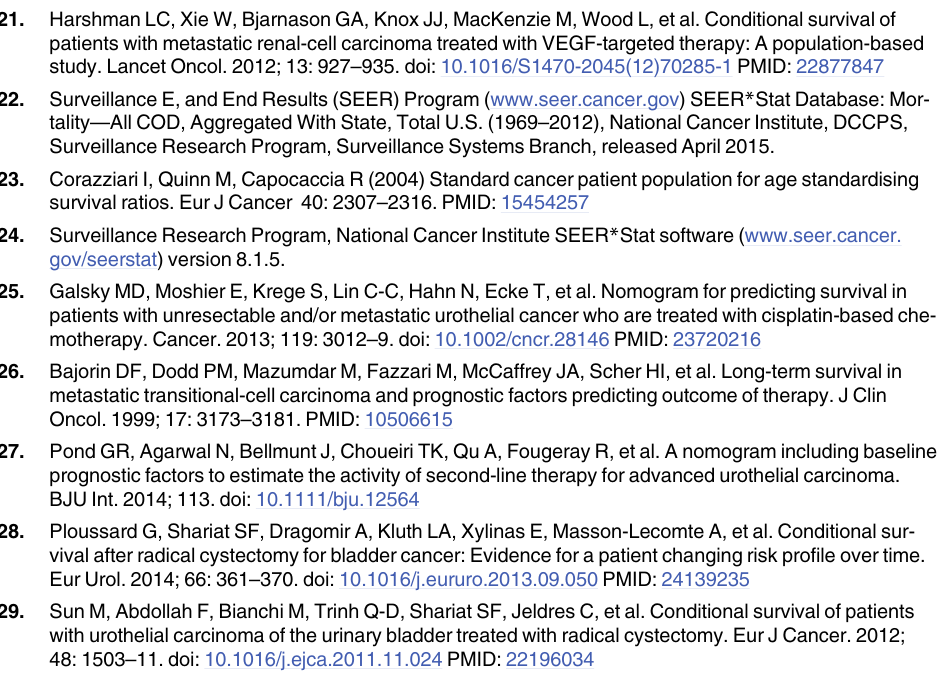
PLOS ONE | DOI:10.1371/journal.pone.0136622 August 26,